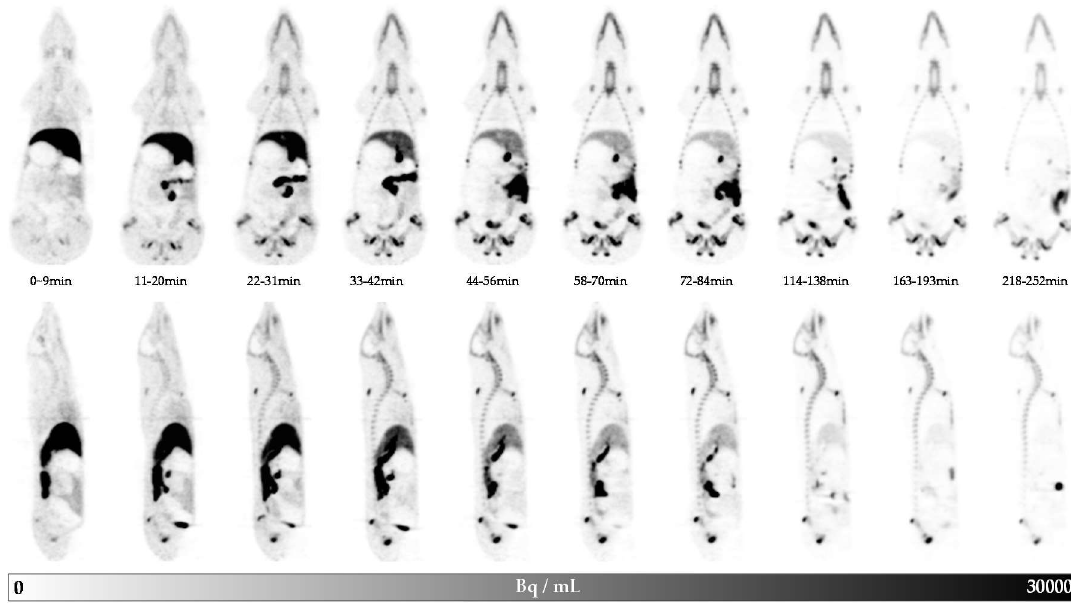
Figure 2. Whole body dynamic positron emission tomography (PET) images in coronal (upper row) and sagittal (lower row) views of pig 1 after intravenous (iv) application of 191 MBq [ 18 F]FACH.